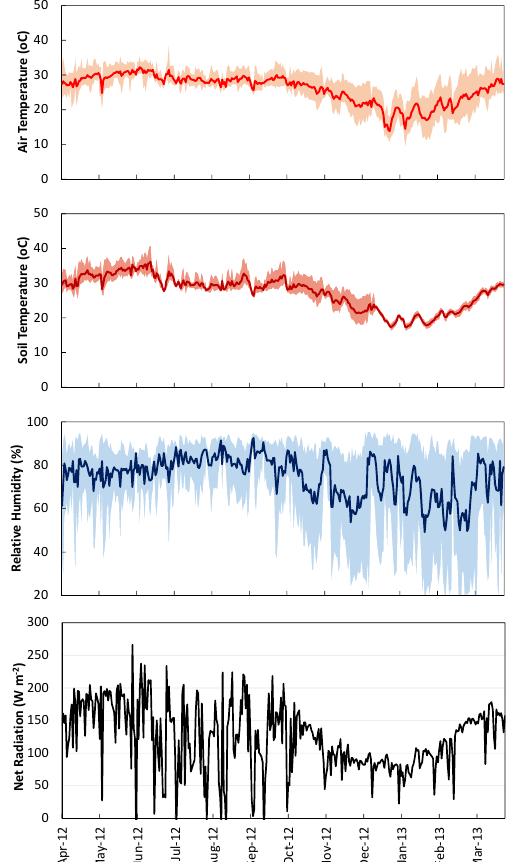
Figure 3. Daily averages of meteorological variables over Sundarbans from April 2012 to March 2013. Bold lines represent the averages and the shaded area represents the min ‐ max range. For net radiation, only average value is depicted.